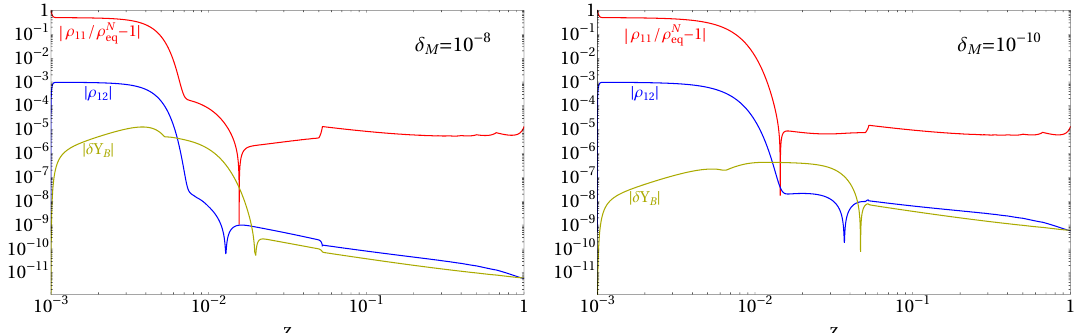
Figure 5. Evolution of (cid:26) 11 ( z ), (cid:26) 12 ( z ) and (cid:14)Y B ( z ) for two di(cid:11)erent values of (cid:14) M . We have (cid:12)xed ! = (cid:25)= 4, (cid:14) = (cid:0) (cid:25)= 2, (cid:24) = 2 and (cid:11) 1 = (cid:11) 2 = 0. The asymmetry for (cid:14) M = 10 (cid:0) 8 is produced earlier but also more strongly washed out with respect to (cid:14) M = 10 (cid:0) 10 case. We found no signi(cid:12)cant dependence of the generated asymmetry on the values of Dirac ( (cid:14) ) and Majorana ( (cid:11) 1 and (cid:11) 2 ) CP phases. In (cid:12)gure 5 we show the deviation from the equilibrium value of N ( (cid:26) ( z ) =(cid:26) N (cid:0) 1) and the mixing between N 11 eq